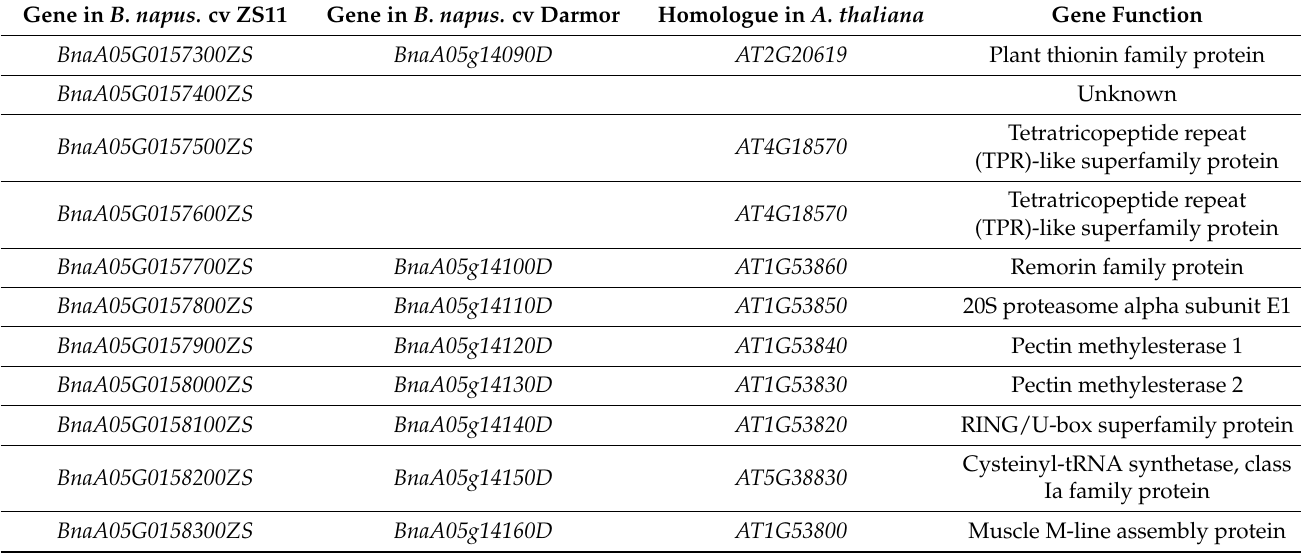
Table 2. Genes in the mapped interval and the Brassica within the interval on the A05 chromosome. Gene in B. napus. cv ZS11 Gene in B. napus. cv